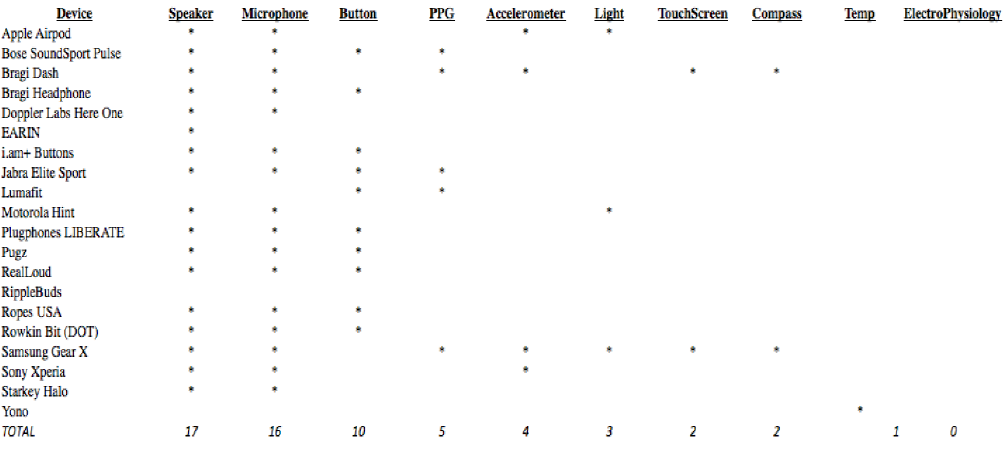
Figure 2. List of hearables devices, and their associated features, that are currently available.